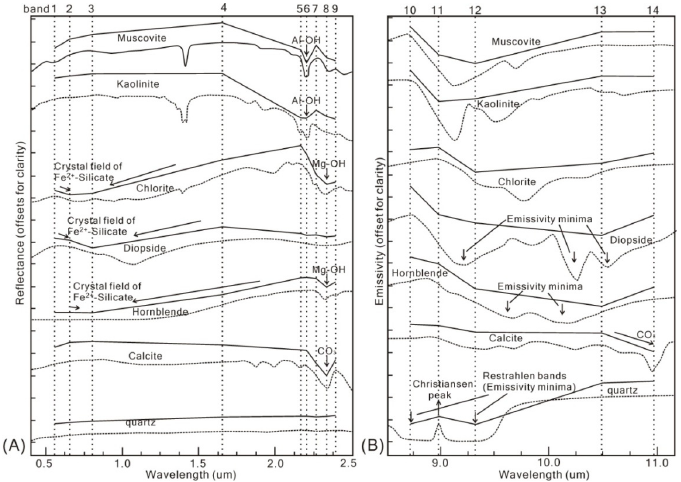
Figure 4. Reflectance ( A ) and emissivity ( B ) spectra of key rock-forming minerals. Dash lines show the laboratory spectral data, which are resampled to ASTER bandpass and shown as solid lines. (Modified from [3,34]).